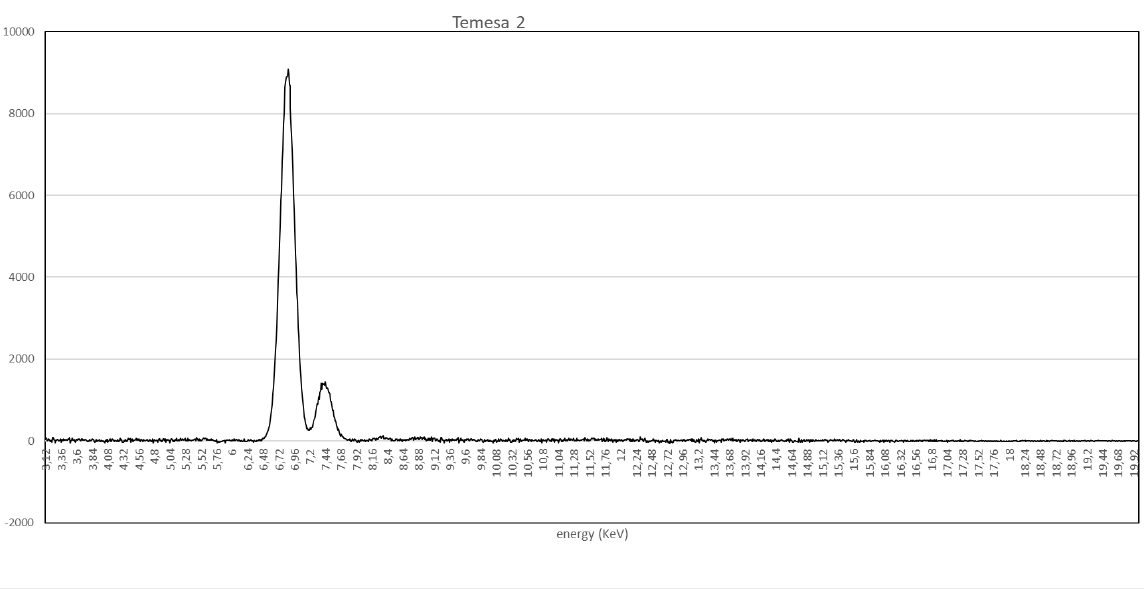
Figure 7. Temesa 2: XRF spectrum.